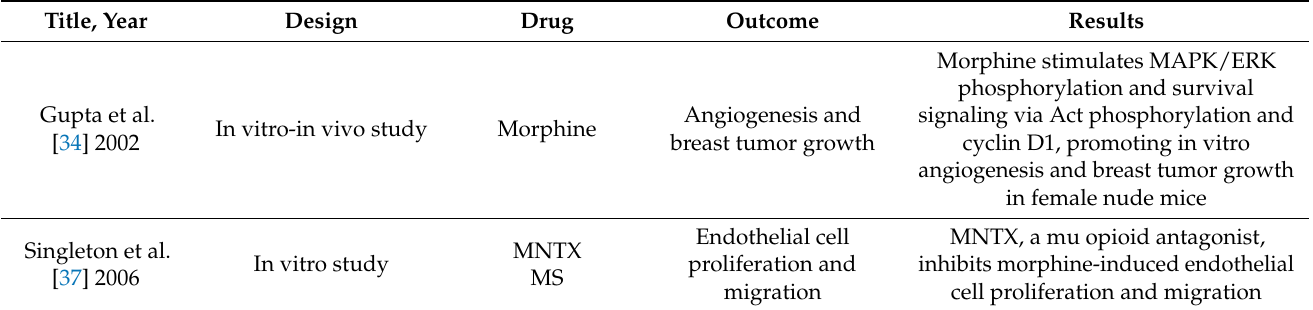
Table 3. Opioids and angiogenesis. Selected preclinical and clinical studies. MAPK: Mitogen-activated protein kinase; ERK: extracellular signal-regulated kinases; MTNX: Methylnaltrexone; MS: Morphine sulfate. Title,